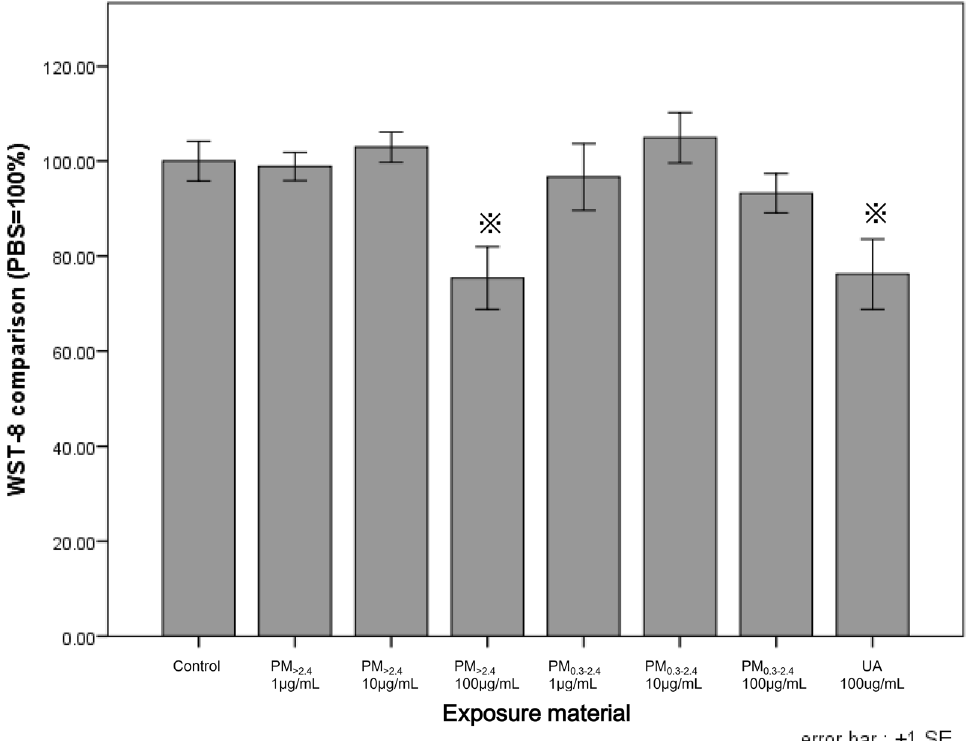
Figure 2. Effects of ambient particles and urban aerosols on reconstructed HCE tissues. Data are expressed as the percentage of cell viability based on the control (0 µg/mL). Each data are mean ± SE of 6 PM >2.4 , 3 PM 0.3–2.4 , 9 UA and 9 control individual cultures. This figure was created using the software SPSS Statistics 24.0 (https :// www.ibm.com/produ cts/spss-stati stics ?lnk=STW_US_STESC H_P1_BLK&lnk2=trial _SPSSs tat&lot=1&pexp=d ef&psrc=none&mhsrc =ibmse arch_a&mhq=spss). * p < 0.05 vs. control (0 µg/mL). HCE human corneal